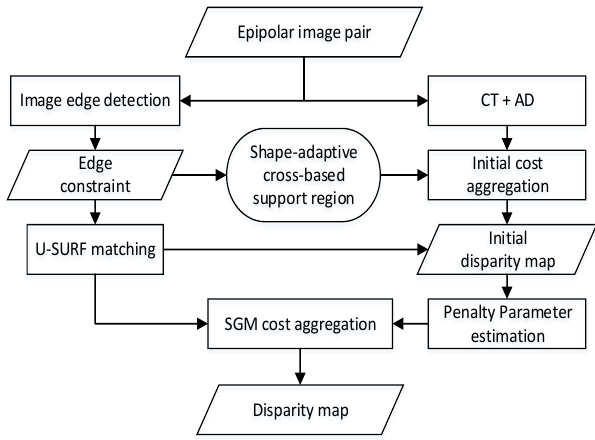
Figure 1. The block diagram of the proposed method.